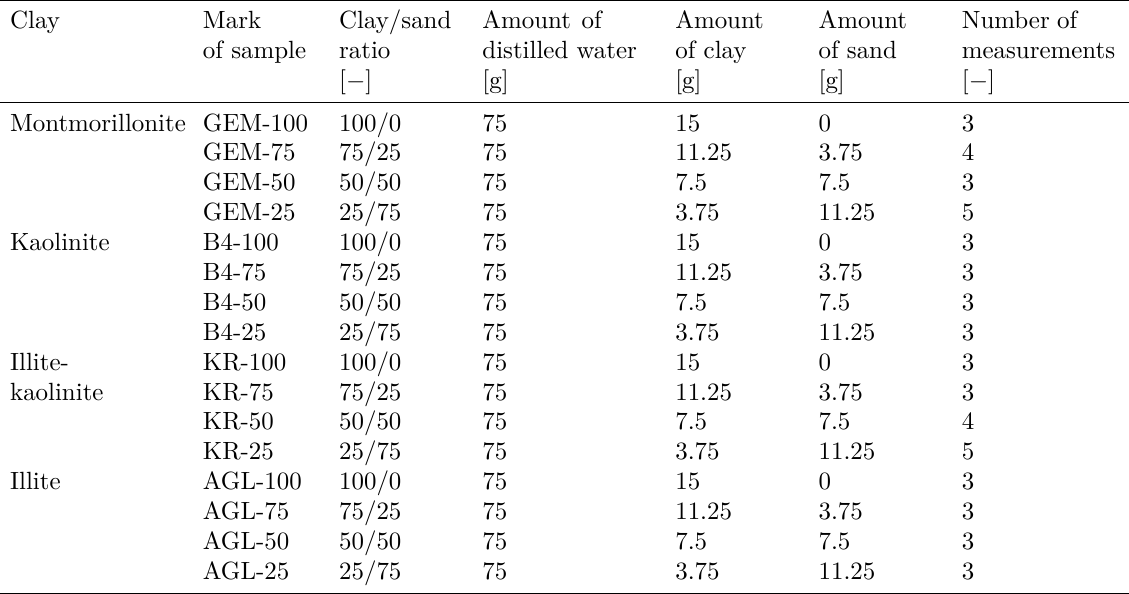
Table 2. Clays used for experimental measurements, their designation and composition.